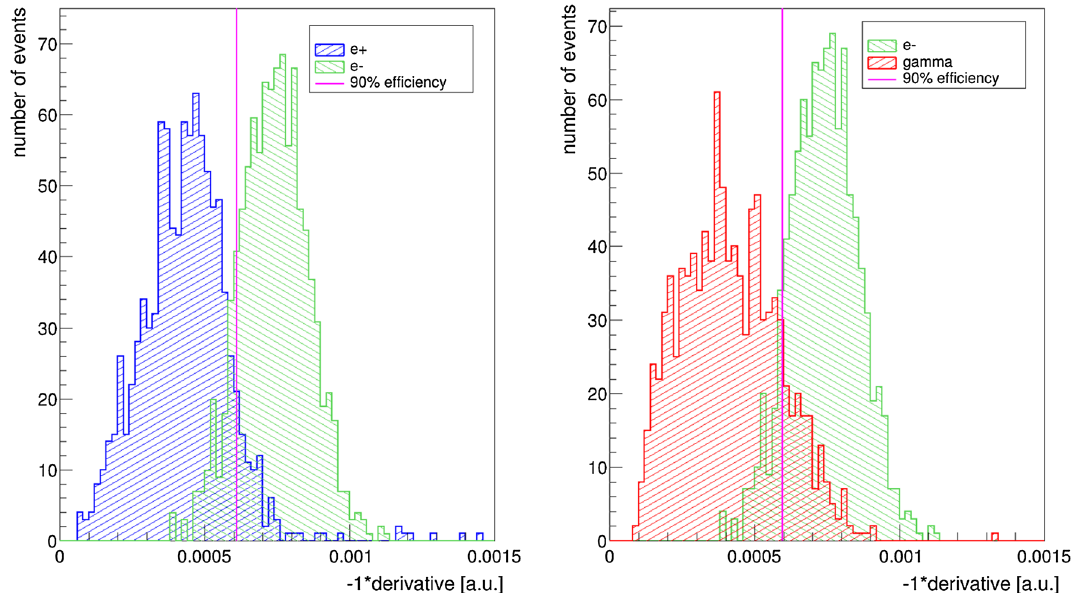
Fig. 3 Maximum derivative of the radial profile of the 3D-topological reconstruction at 2 MeV in JUNO for (left) electrons and positrons and (right) electrons and gammas